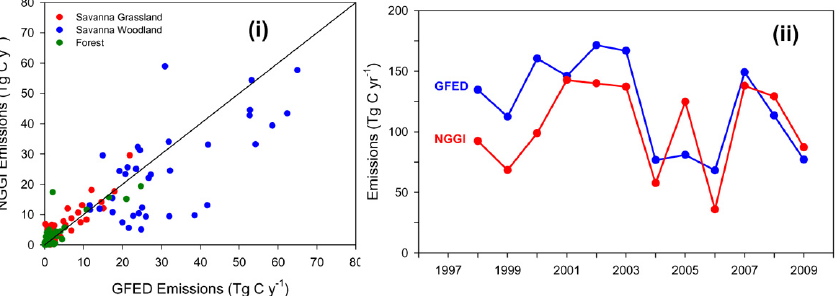
Fig. 10. Comparison of GFED3 and NGGI CO 2 -C gross fire emission estimates. (i) Annual fluxes per state per vegetation class; (ii) total annual Australian continental fire emissions